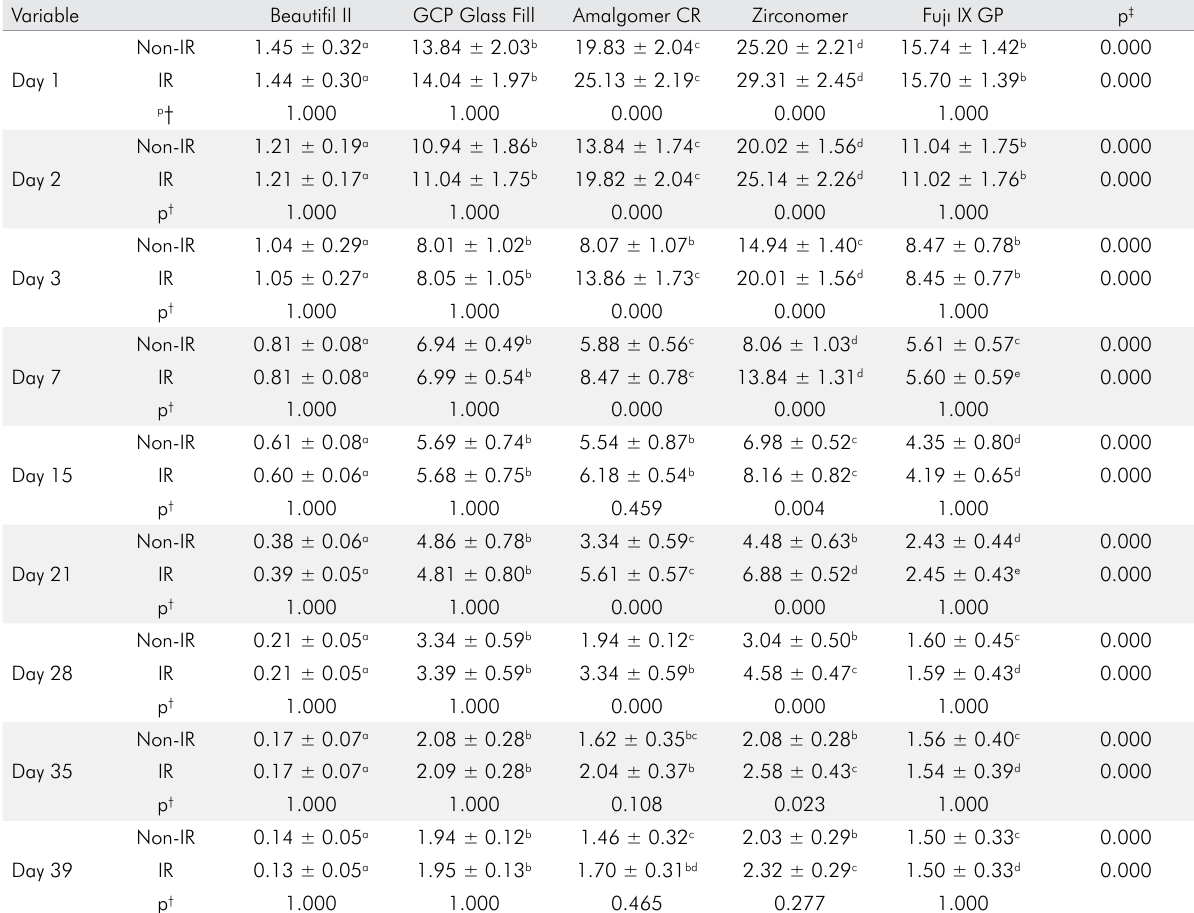
Table 2. Mean and standard deviation values of the amounts of fluoride release (ppm) for each material and subgroup (Non-IR; non-irradiated, IR; irradiated) during the 39-day